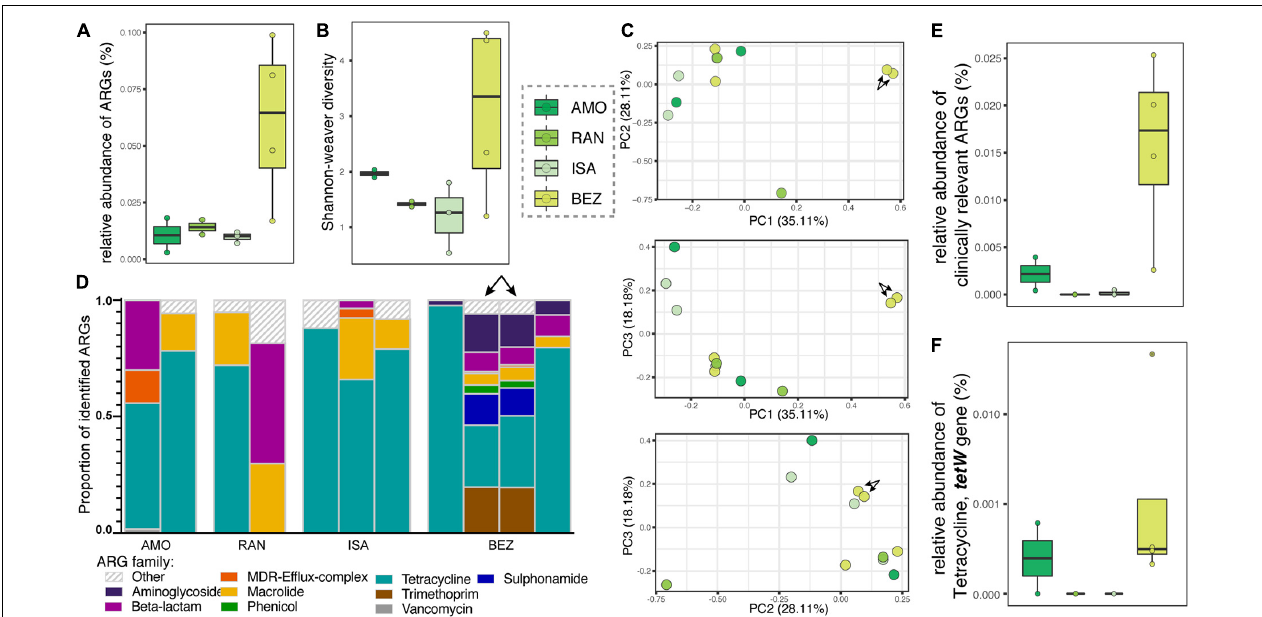
FIGURE 5 | Antibiotic resistance genes in soil samples from four sites in Madagascar, representing different levels of anthropogenic disturbance. Shown are (A) relative abundance, (B) alpha diversity, (C) principal coordinate analyses of Bray–Curtis dissimilarity, including combinations of axes 1, 2, and 3, (D) proportions of identified ARGs by gene family, (E) relative abundances of all clinically relevant ARGs, and (F) relative abundances of the tetW gene. Gene families were identified by color and those representing < 1% of the ARGs were combined into the category “Other.” Sites are presented in ascending order according to the ranked level of disturbance ( Table 1 ). Arrows in panels (C,D) point to two soil samples from BEZ that cluster distinctly, reflecting their unique composition.